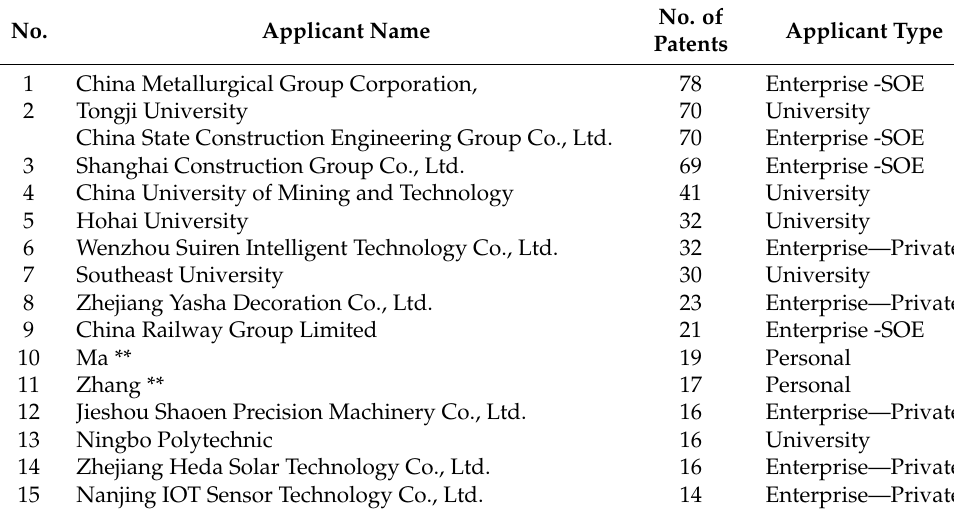
Table 3. Main applicants in the identified fourteen